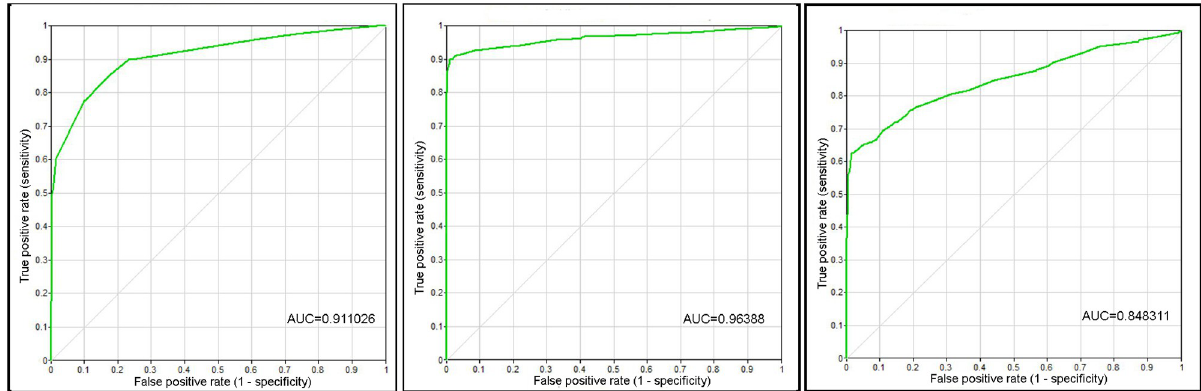
Fig 3. The receiver-operating characteristic (ROC) curve of the BNM. (a) Nankeen Kestrel data set, (b) Straw-necked Ibis data set, (c) Cattle Egret data set.